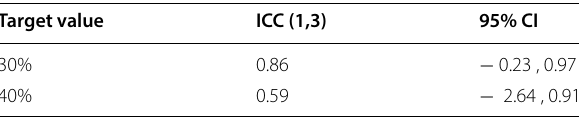
Table 7 ICC at each target value in the “no tablet display”